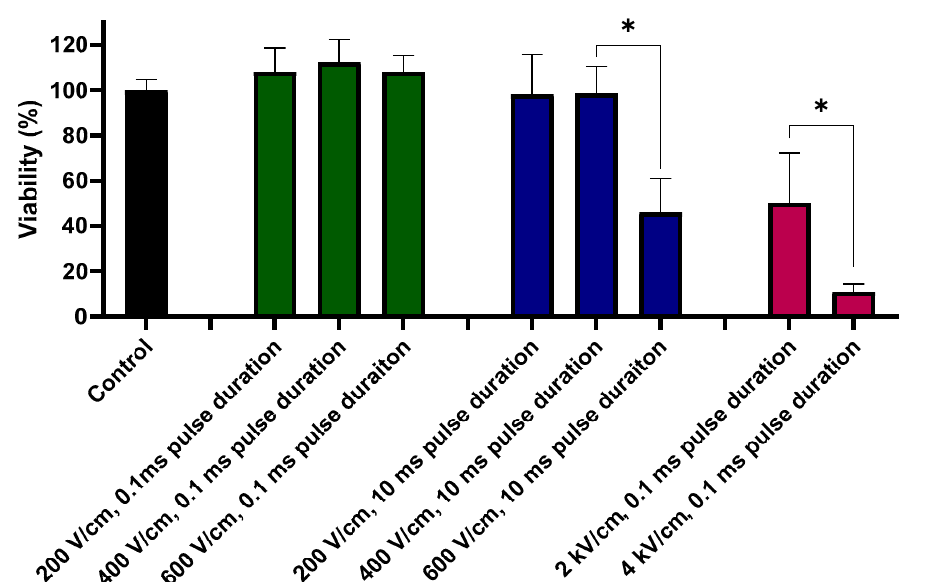
Figure 3. Viability (%) of the cells after standard IRE protocol (2 and 4 kV/cm, 0.1 ms pulse duration, 8 pulses), 200–600 V/cm, 0.1 ms pulse duration, 8 pulses PEFs and PEFs with the elongated pulse duration (200–600 V/cm, 10 ms pulse duration, 8 pulses). Green bars represent 200–600 V/cm, 0.1 ms pulses; blue bars represent 200–600 V/cm, 10 ms pulses; red bars represent 2–4 kV/cm, 0.1 ms pulses. Data presented as average ± SD. One-way ANOVA test analysis: * p < 0.0001.